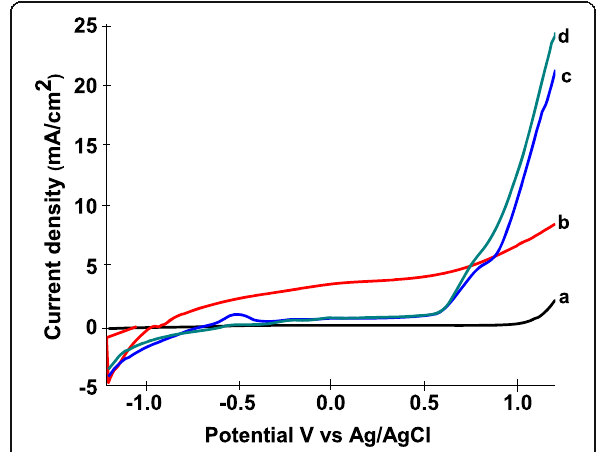
Fig. 9 LSV of a FTO, b GO/FTO, c CuO/FTO, and d GO/CuO/FTO at 100 mv/s scan rate Fig. 10 LSV of GO/CuO/FTO electrode with variable scan